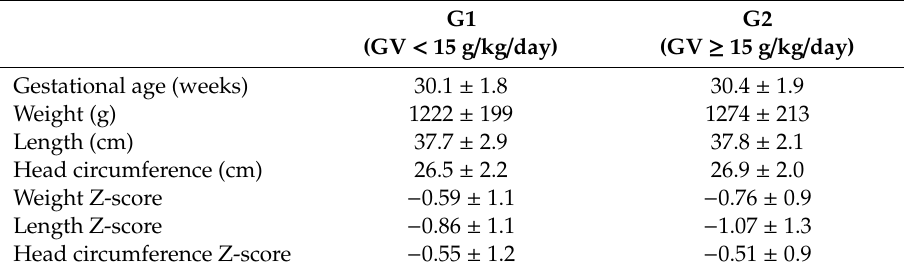
Table 1. Basal characteristics at birth according to weight growth velocity (GV) categorization.